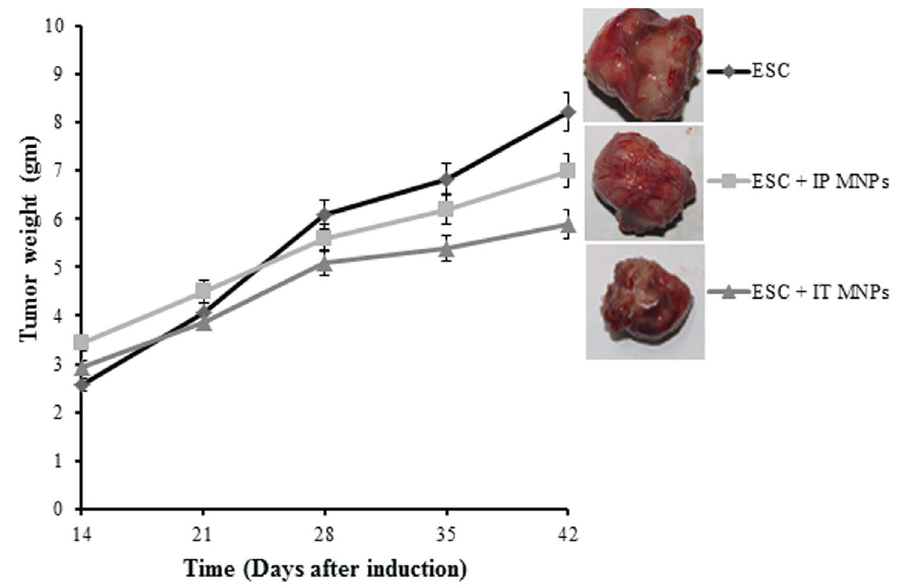
Figure 6. Antitumor effect of MNPs administration on Ehrlich solid tumor growth in mice. Ehrlich tumor bearing mice untreated with MNPs ( ¤ ), Ehrlich tumor bearing mice treated IP with MNPs ( & ) and Ehrlich tumor bearing mice treated IT with MNPs ( m ). Each point represents the mean 6 SE. n=6. Representative images of tumor were shown for each group. Images were at the same magnification level.